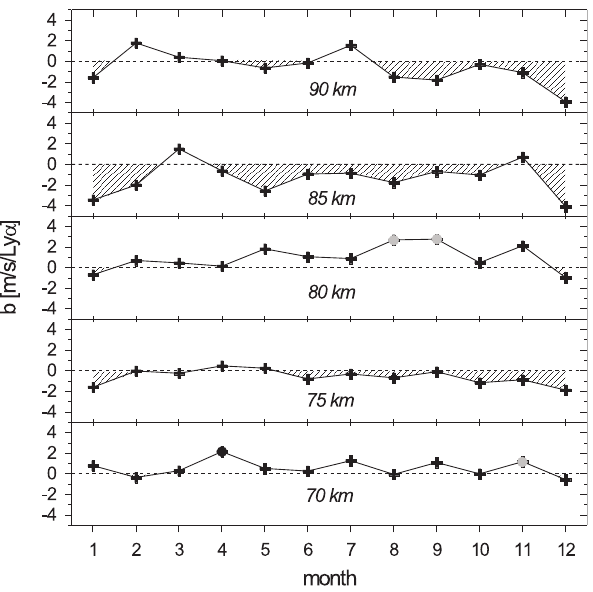
Fig. 10. Seasonal variation of the partial regression coefficient b (see Eq. 1) between the amplitude of the semidiurnal tide at Julius- ruh and the solar activity for different heights. Significance level χ is marked by black dots ( χ ≥ 95%), grey dots ( χ ≥ 90%), and crosses ( χ< 90%).